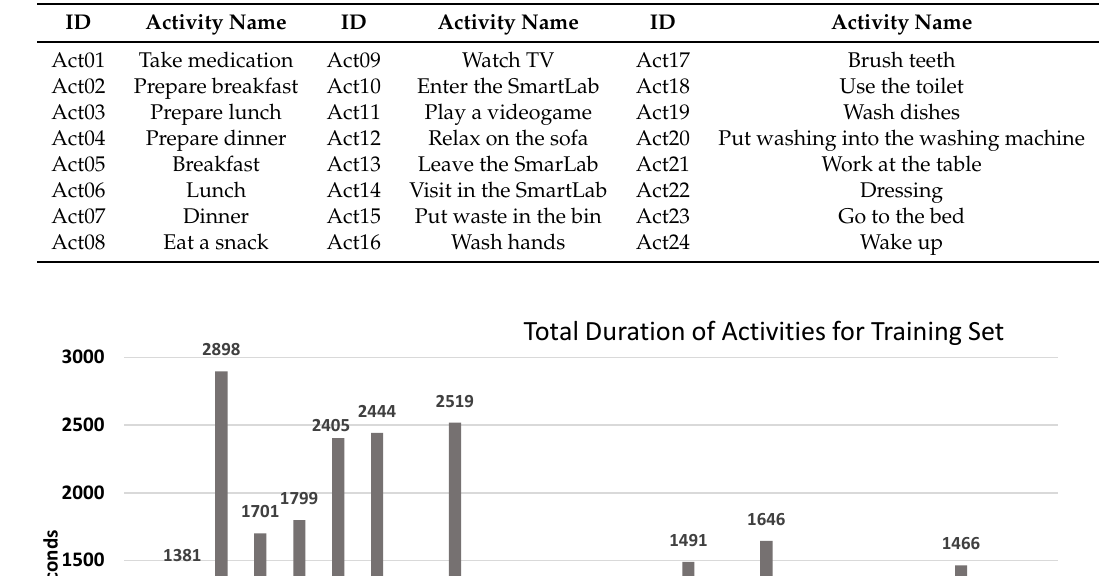
Table 1. List of activities recorded in the UJAmI Smart Lab Training and Test dataset